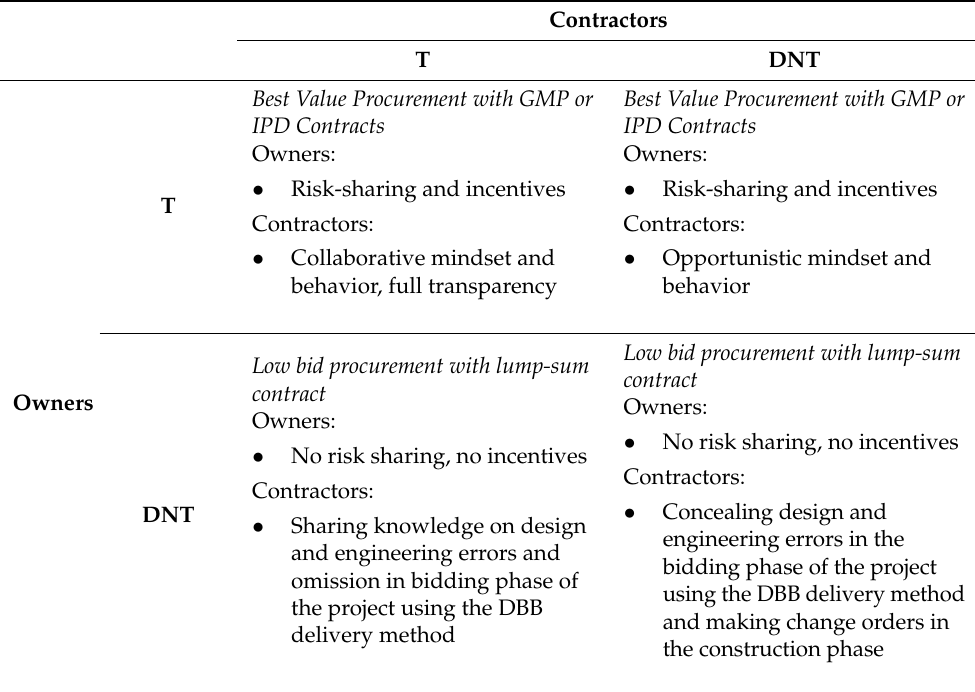
Table 5. An Owner’s and contractor’s tacit knowledge sharing and collaboration scenarios in the context of different procurement and contract